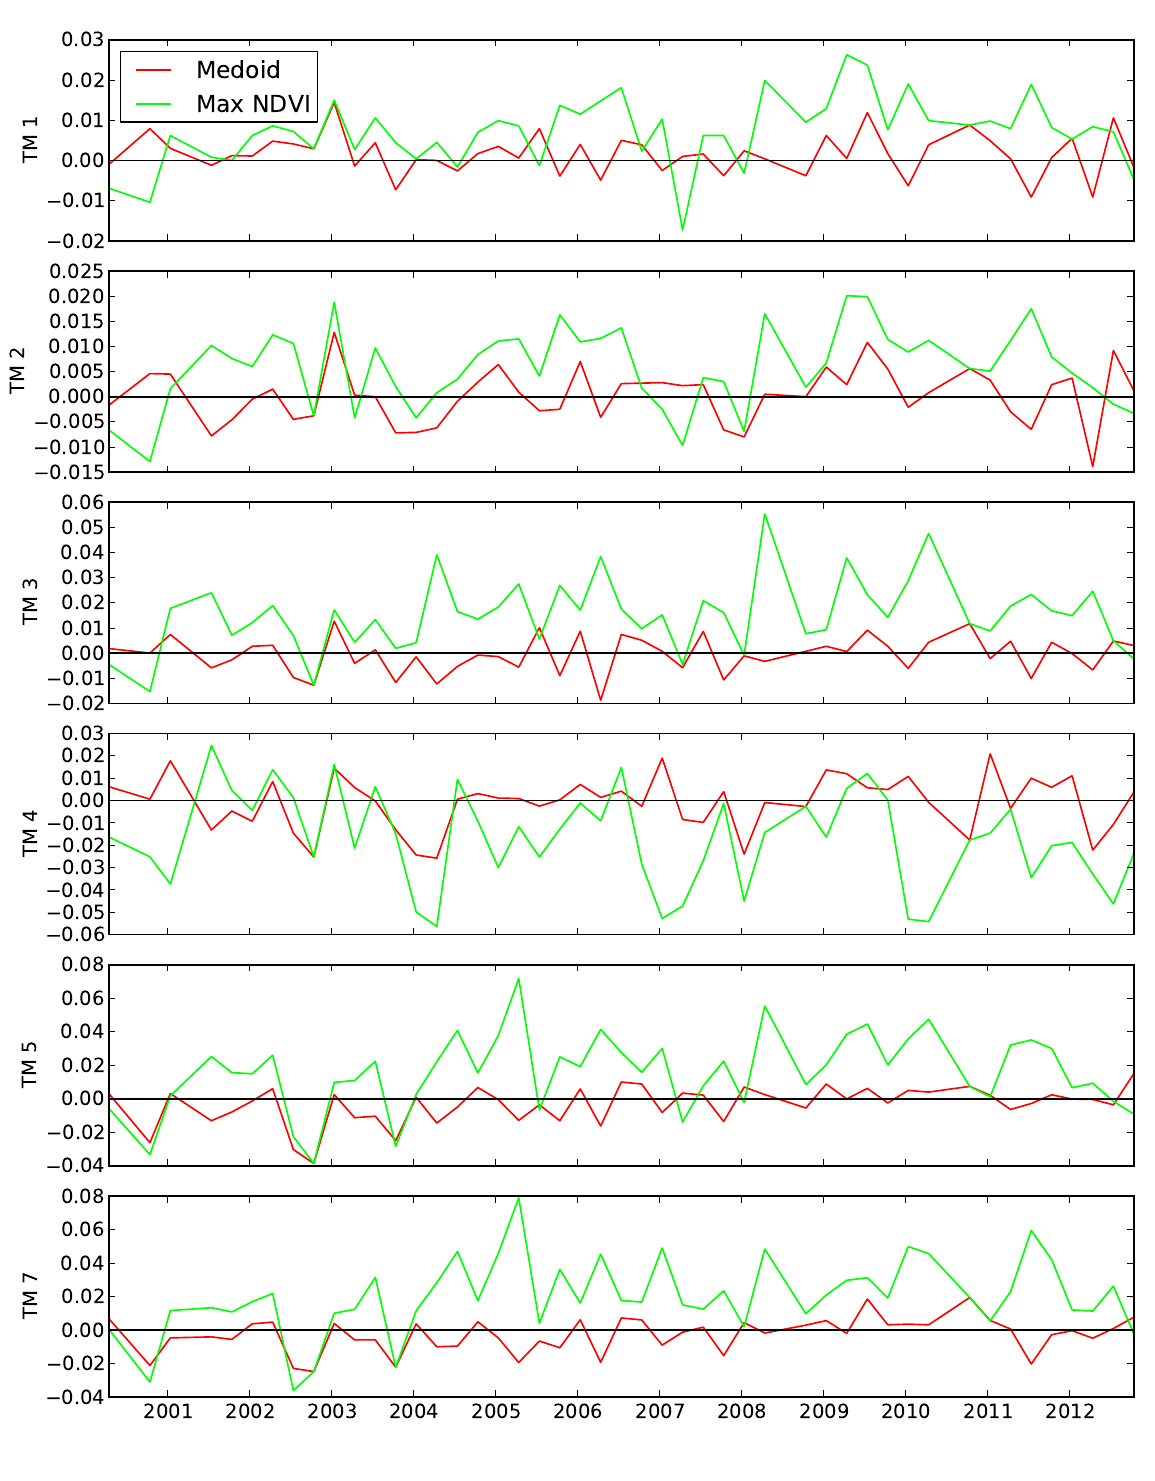
Figure 8. Seasonal average residuals for all Landsat TM reflective bands, for the grassland example